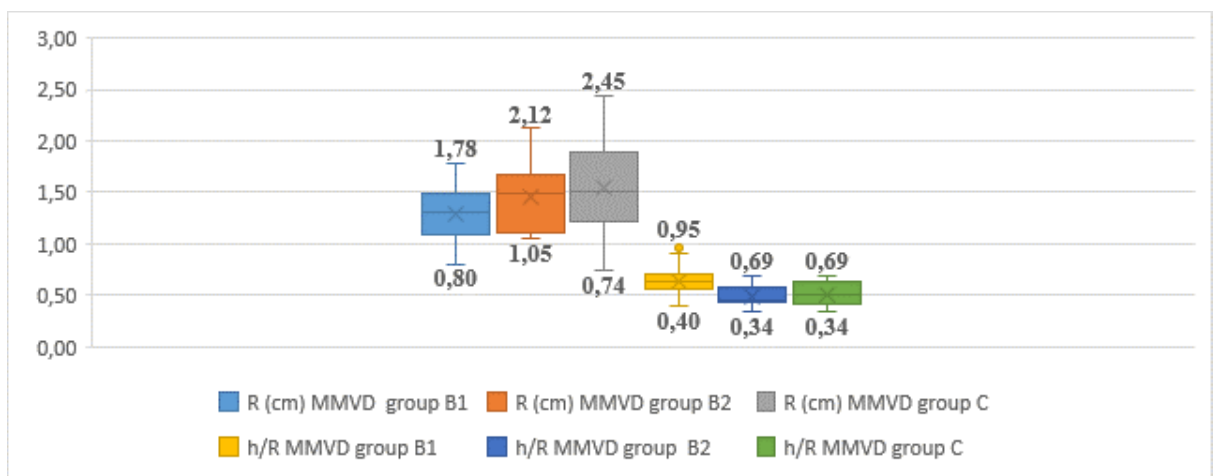
Fig. 1. Box and whisker plot showing the radius of the LV cavity in diastole (R) and the ratio of the thickness of LVPWd (h) to R in dogs of experimental groups with the progression of MMVD with indication of